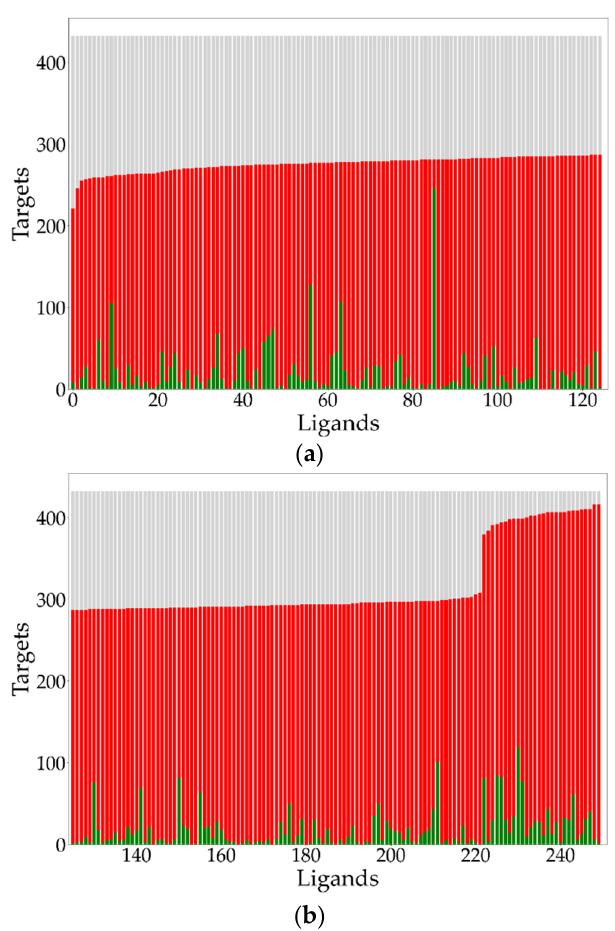
Figure 5. ( a ) Ligand activity profiles for the first 125 ligands out of the set of 250 ligands. ( b ) Ligand activity profiles for the remaining 125 ligands out of the set of 250 ligands. For each ligand, the number of active, inactive, and null targets are shown as green, red, and grey bars, respectively. The ratio of the number of active plus inactive targets (green plus red bars) for the l- th ligand divided by the number of targets (green plus red plus grey bars), represents the ligand-based LDC with respect to the l- th ligand, i.e.,